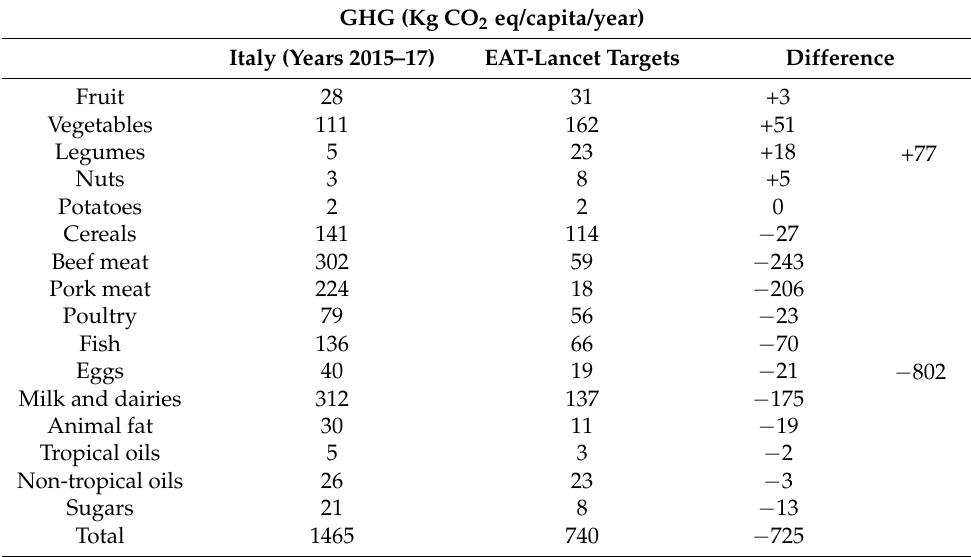
Table 4. Annual greenhouse gas (GHG) emissions related to the amounts of foods available for consumption in Italy at the last available observation (years 2015–2017) as compared to that induced if food consumption would adhere to the targets of the Eat–Lancet